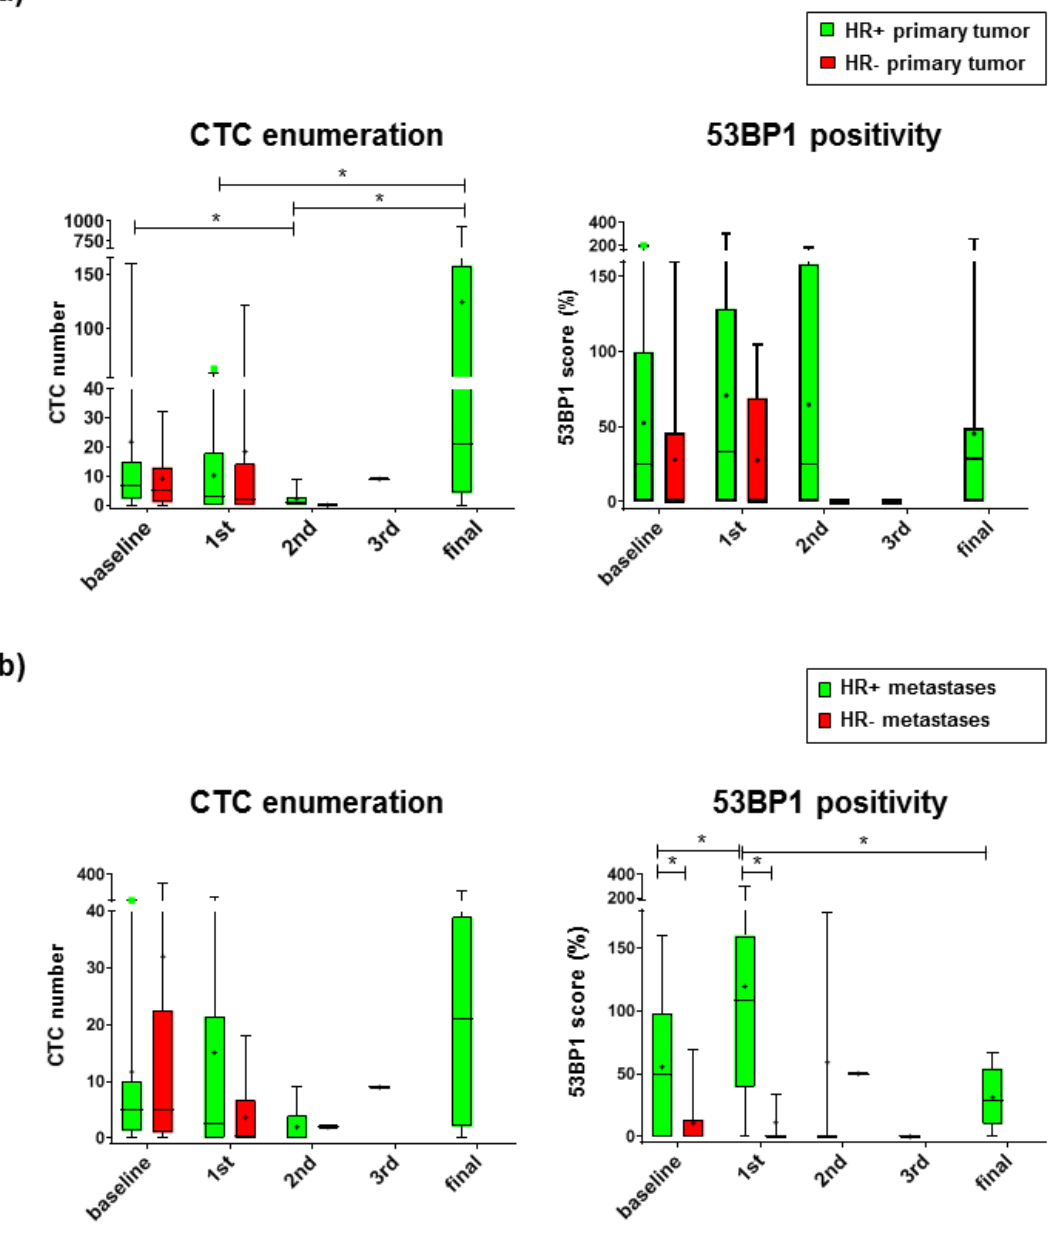
Figure 2. Comparison of CTCs as a function of the HR status in primary tumors or metastases. CTCs from patients with HR + and HR- primary tumors ( a ) or metastases ( b ) were enumerated and 53BP1 scores determined. Data are shown in box plots with the mean value (dot), median (line), and 95% confidence intervals (CI) (whiskers). For numbers of independent blood samples (N) obtained during different visits, see Supplementary Figure 2. * P < 0.05, Kruskal–Wallis test followed by the Mann–Whitney U test. For individual patient scores, see Supplementary Figure 2c.